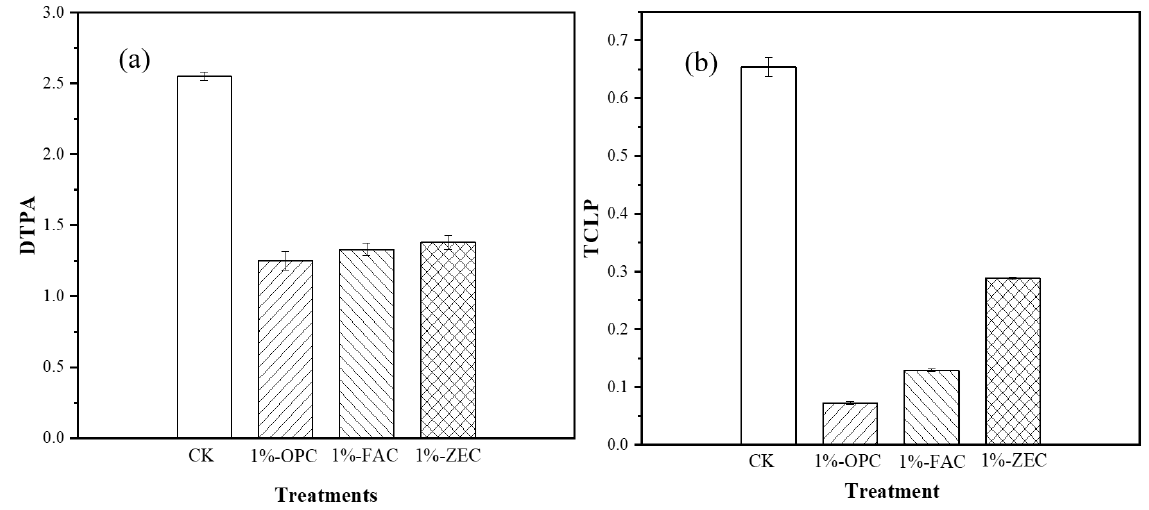
Figure 5. Amendments effect on Cd bioavailability and leachability. Notes: ( a ) Amendments effect on Cd extracted with DTPA; ( b ) Amendments effect on Cd TCLP. Treatments: control (CK), cement paste (OPC), fly ash cement (FAC) paste, and zeolite cement (ZEC) paste.